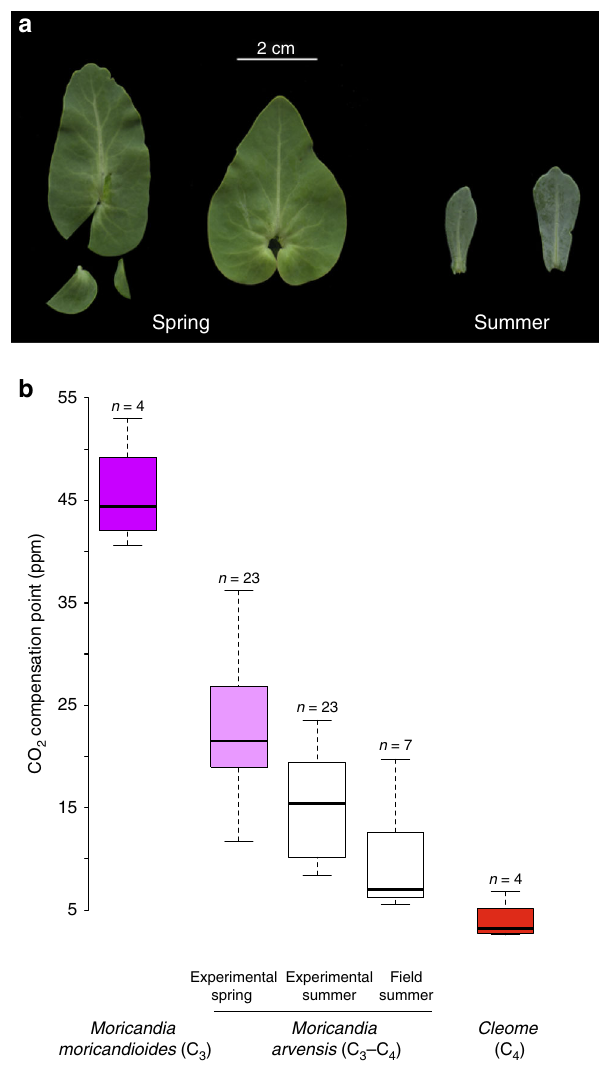
Fig. 1 Plasticity in foliar and physiological traits. a Moricandia arvensis leaves in spring and summer (leaves belonged to the same individual). b Box-plot showing the median, quartiles and interval con fi dences of the CO 2 compensation points of the plants in spring (lilac box) and summer experimental conditions (the same plants replicated in each condition) and in summer in fi eld conditions (white boxes). For comparison, we have added information from the C 3 species Moricandia moricandioides (purple box, own data) and C 4 species of the genus Cleome (red box), the closest C 4 plants to Moricandia (see “ Methods ” section for